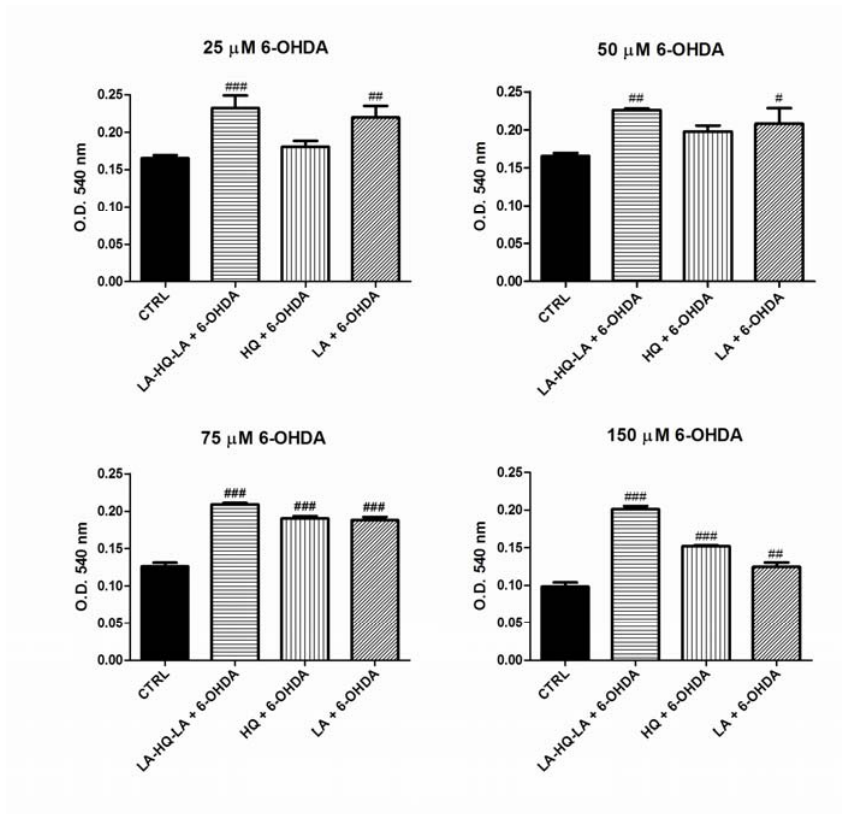
Figure 7. Neuroprotective effects of LA, HQ, and LA-HQ-LA in undifferentiated and 6- OHDA-lesioned SH-SY5Y human neuroblastoma cells a